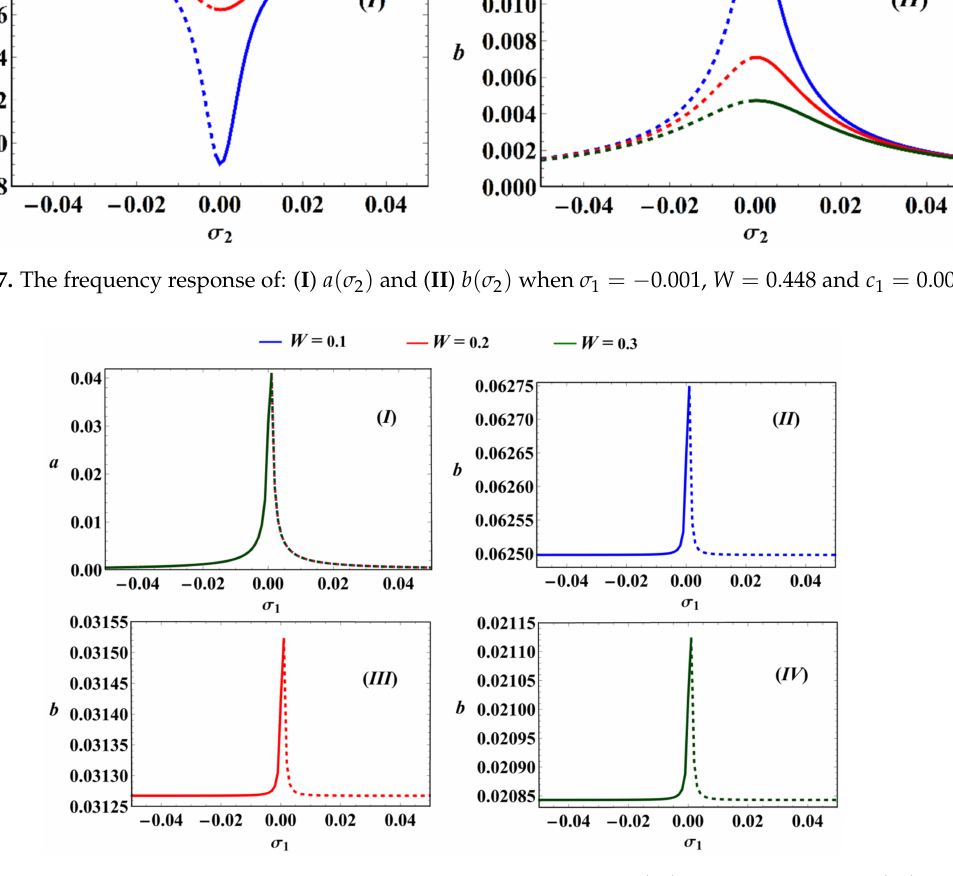
Figure 18. The frequency response at σ 2 = 0.001, c 1 = 0.001, and c 2 = 0.011 of: a ( σ 1 ) as seen in ( I ), and b ( σ 1 ) as shown in ( II ) at W = 0.1, ( III ) at W = 0.2, and ( IV ) at W = 0.3.